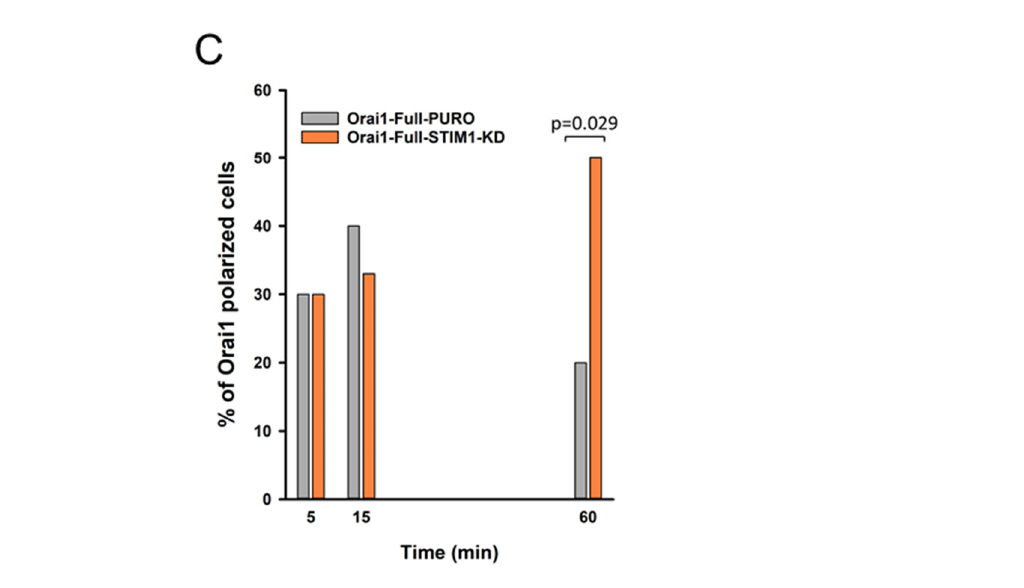
Figure 3. The Orai1-Full channel in STIM1 knockdown cells show unrelenting accumulation into the immunological synapse. Confocal images of the immune synapse formed between Jurkat cells expressing the mGFP-Orai1-Full channels ( A ) in STIM1-KD and ( B ) PURO cells and CD3-CD28 antibody coated beads. ( A1 , B1 ) The mGFP-tagged Orai1-Full channels in STIM1-KD and PURO cells are shown in green. ( A2 , B2 ) Alexa-546 phalloidin (red) label of cells (IS reporter). ( A3 , B3 ) Merged images of green (Orai1) and red (phalloidin) fluorescence signals. ( A4 , B4 ) Brightfield images of STIM1-KD ( A1 – A3 ) and PURO ( B1 – B3 ) cells expressing the mGFP-Orai1-Full channels. Beads are indicated with an asterisk. Scale bar is 10 µm. ( C ) The percentage of cells with the polarized Orai1- Full channel distribution upon IS formation with CD3-CD28 antibody coated beads at 5th, 15th and 60th minute in mGFP-Orai1-Full-STIM1-KD (orange) and mGFP-Orai1-Full-PURO (grey) cells. 30 cells were evaluated at each time point.